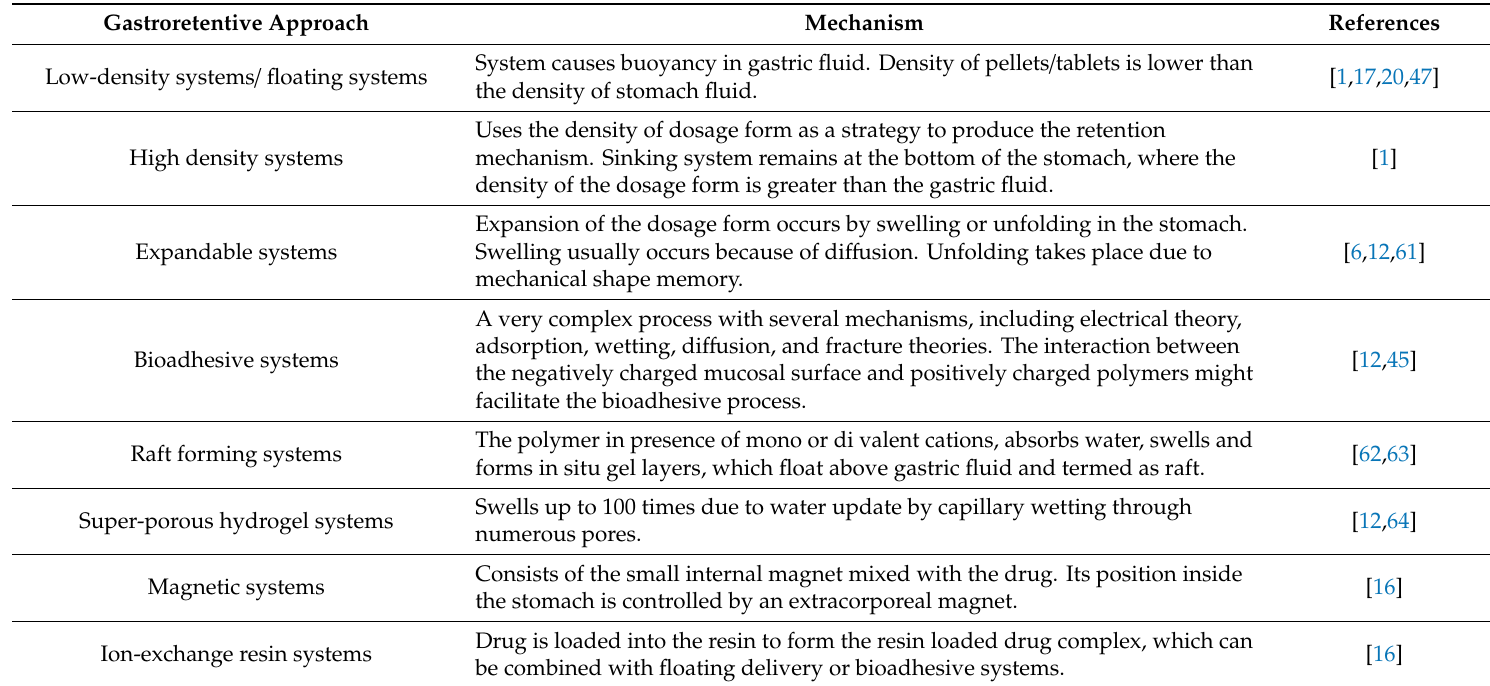
Table 4. Summarized mechanisms of the various